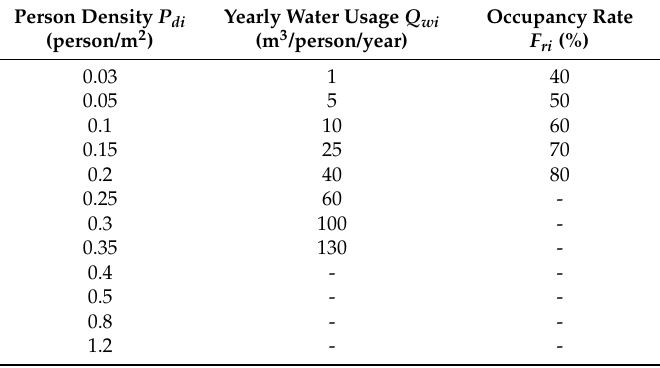
Table 1. Standardized water usage baseline parameter